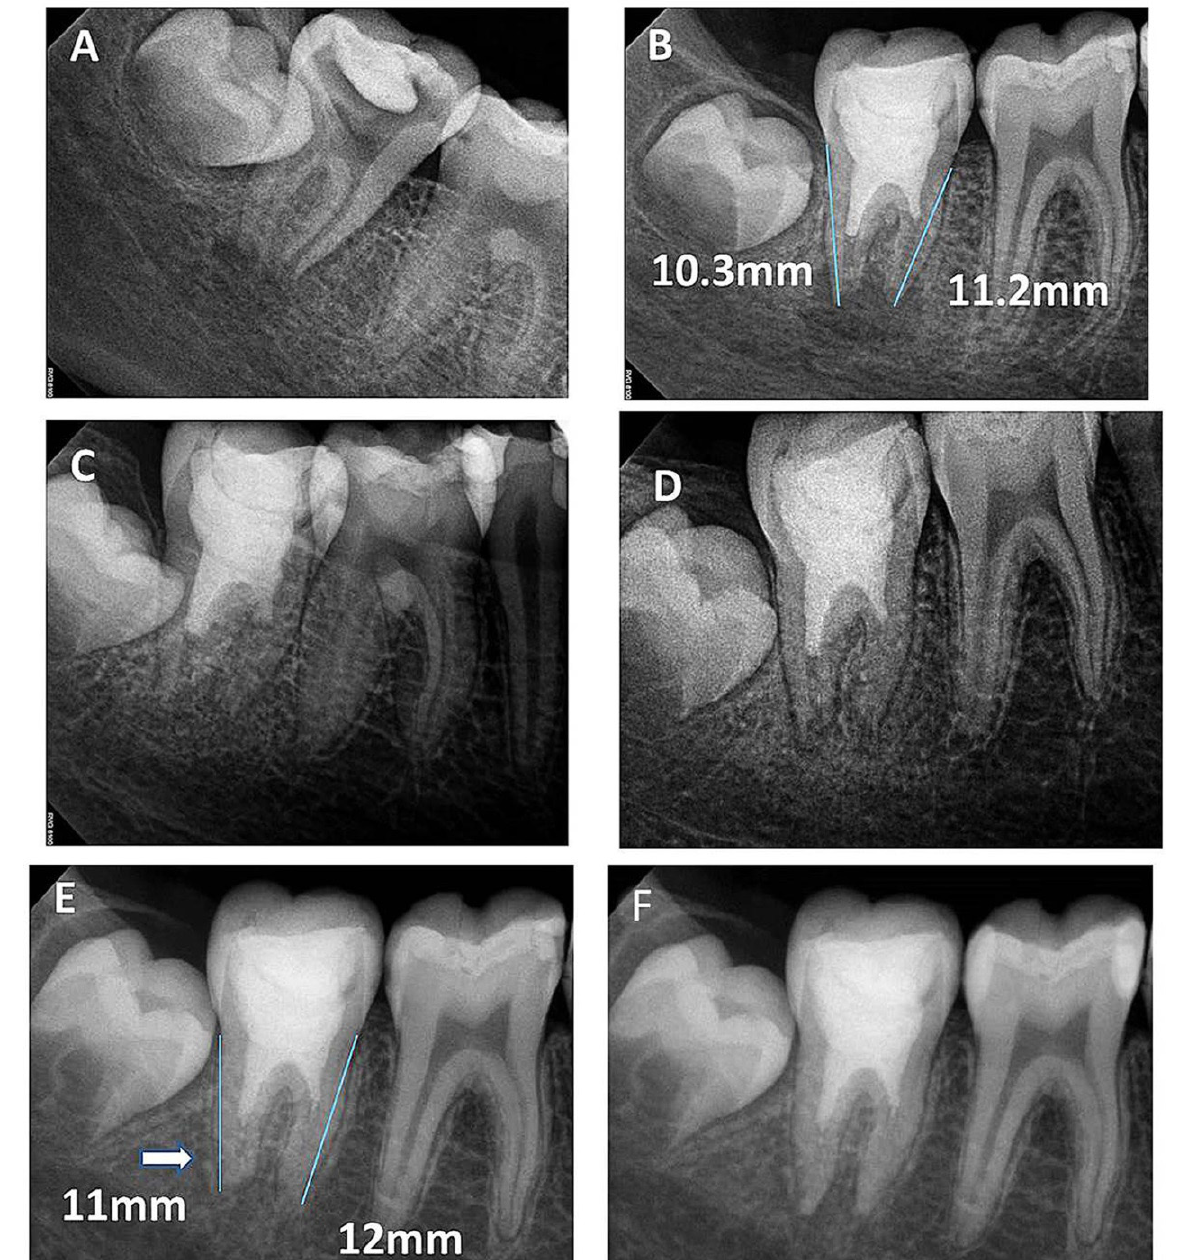
Figure 3. ( A ) Periapical radiograph of nonvital tooth #47 of a 9-year-old with wide open apex and periapical radiolucency; ( B ) immediate post-treatment radiograph showed MTA plug in the coronal third and composite restoration. The mesial root length was 11.2 mm and the distal was 10.3 mm; ( C ) a follow-up photoradiograph after 6 months showed a complete resolution of the periapical radiolucency; ( D ) follow-up photoradiograph at 12 months showed a decrease in apical canal width with evidence of mesial canal calcification; ( E , F ) Follow-up photoradiographs at 24 months and 8 years showed calcification of the apical distal canal and progressive mesial canal calcification.